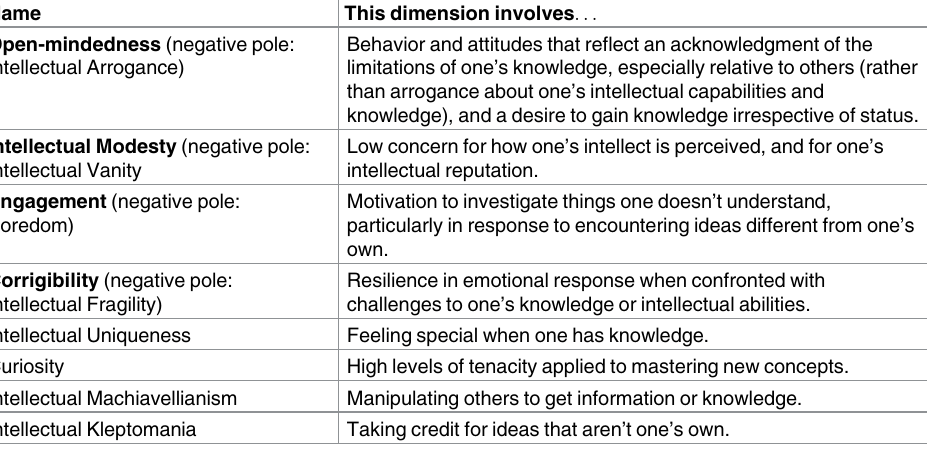
Table 1. Namesand qualitative descriptions of the 8 factors suggested by the exploratory factor anal- ysis of the results of study 1. In bold are the factors determined to be central to intellectual humility.